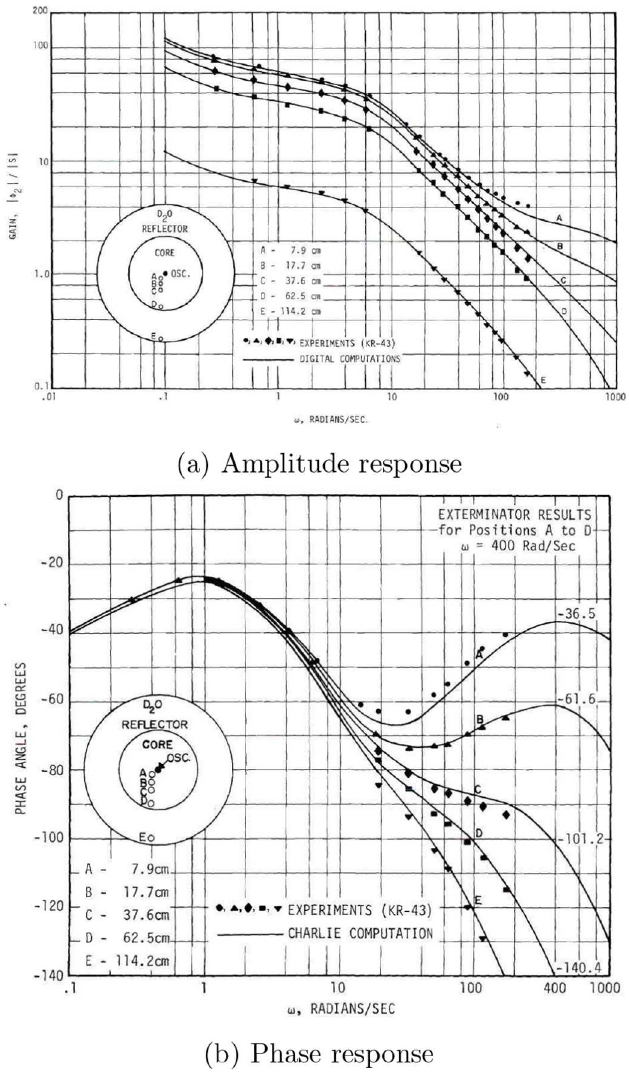
Fig. 3. Experimental transfer function of the NORA reac- tor (Institute for Energy Technology, Norway) compared with computations [42].